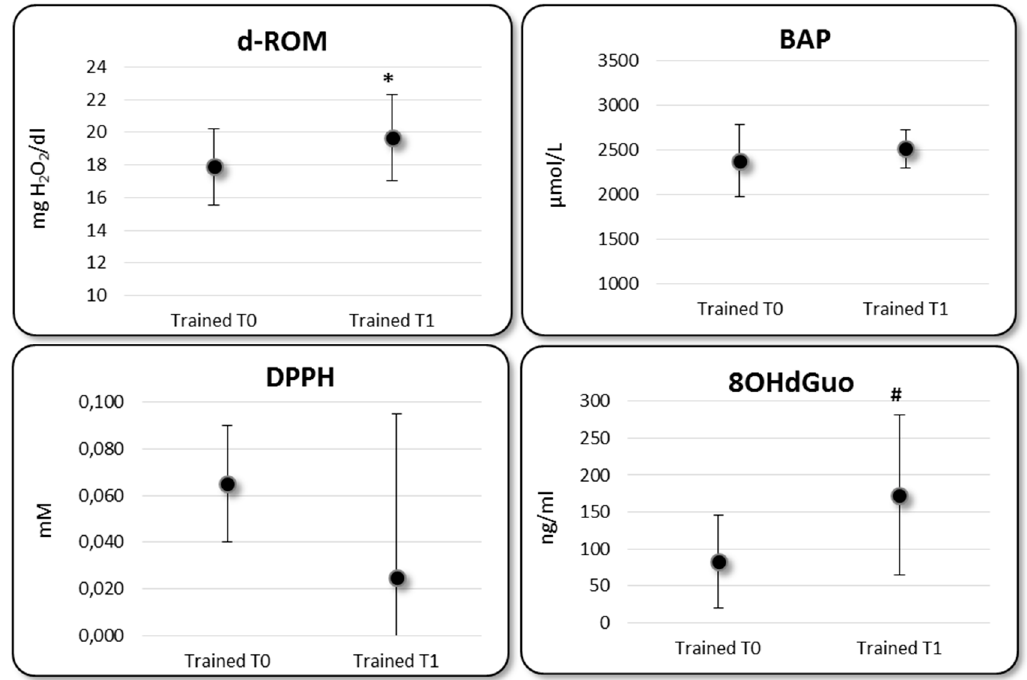
Figure 2. Biomarkers of OS status in trained subjects at T 0 and T 1 time (* p = 0.030 Trained T 0 vs. T 1 ; # p = 0.049 Trained T 0 vs. T 1 ).